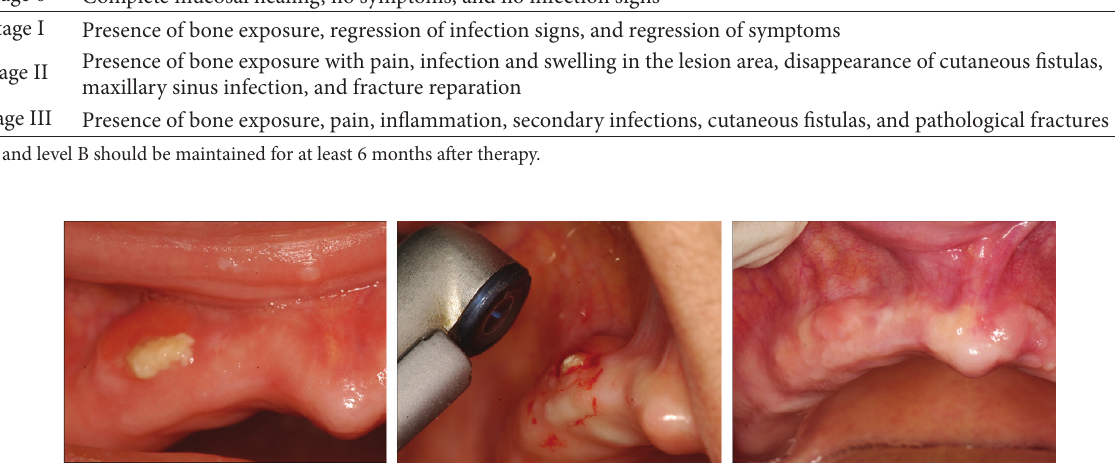
Figure 1: Maxillary stage I BRONJ developed in a patient who received infusions of zoledronic acid for metastasis of a breast cancer. Successfull treatment with Er:YAG